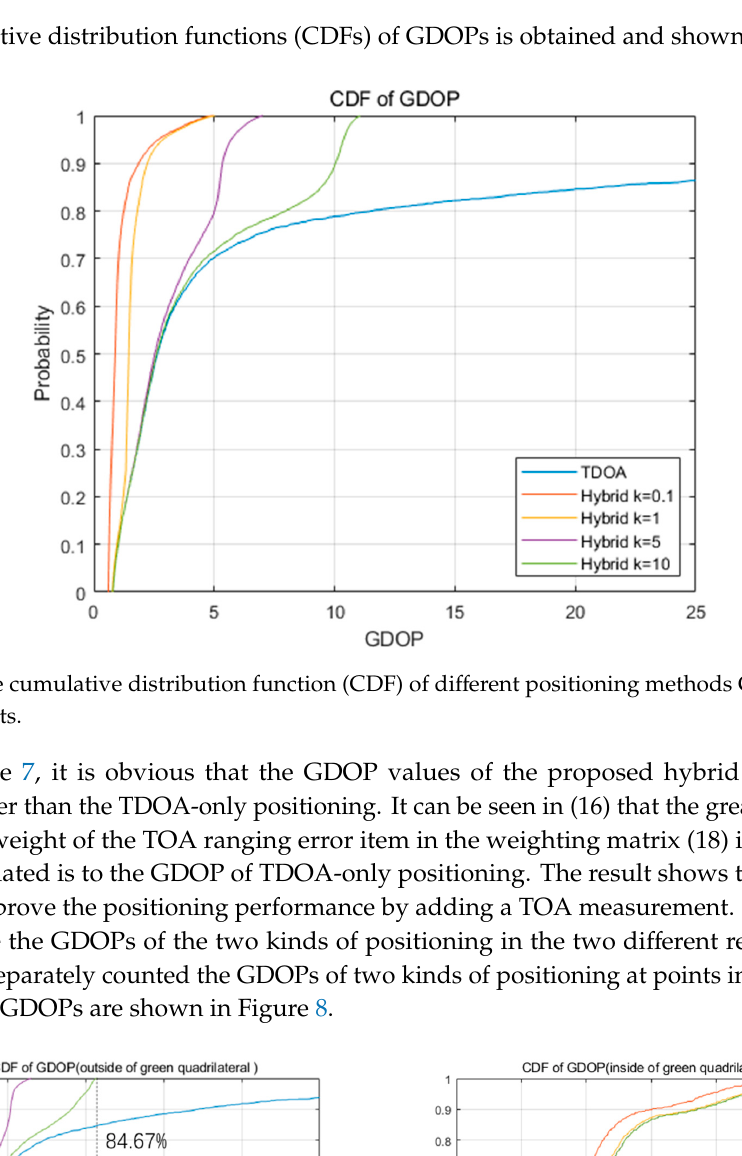
Figure 6. GDOP of TDOA positioning in the developed indoor 2D simulation scenario. The red dots are ANTs.